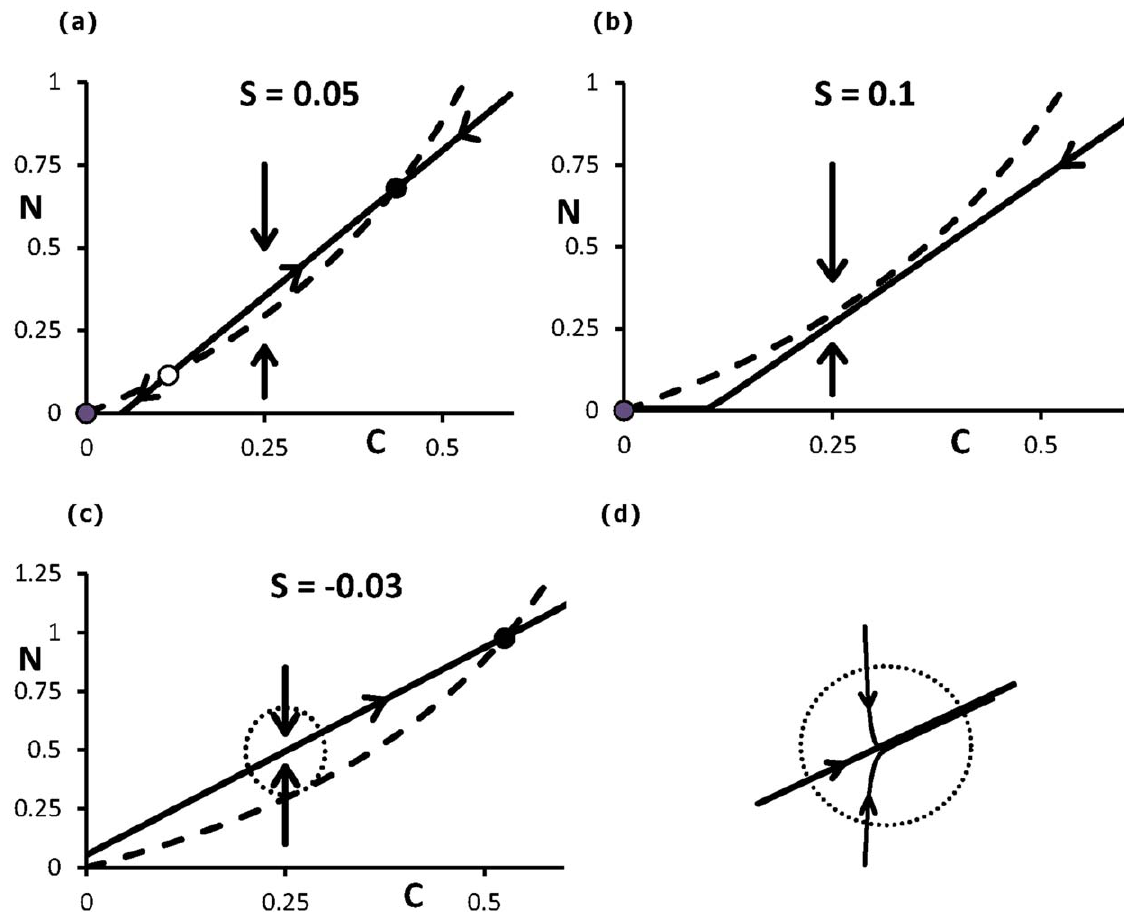
Figure 2. The dynamics of the system (1ab). The equilibria are at the intersection of the two nullclines, dN/dt =0 (solid) and dC/dt= 0 (dashed). If starting in an arbitrary point of the plane the system rapidly moves to a quasi-steady state near the nullcline dN/dt =0. Along this curve it goes next more slowly in the direction of a stable equilibrium: (a) For a control S =0.05 there are two stable equilibria ( smoking. (b) For S =0.1 only the (stable) no-smoking equilibrium is left. (c) For S = 2 0.03 only the smoking equilibrium is left as stable limit solution. (d) Blow up of approach of quasi-steady state, see Figure 2c.